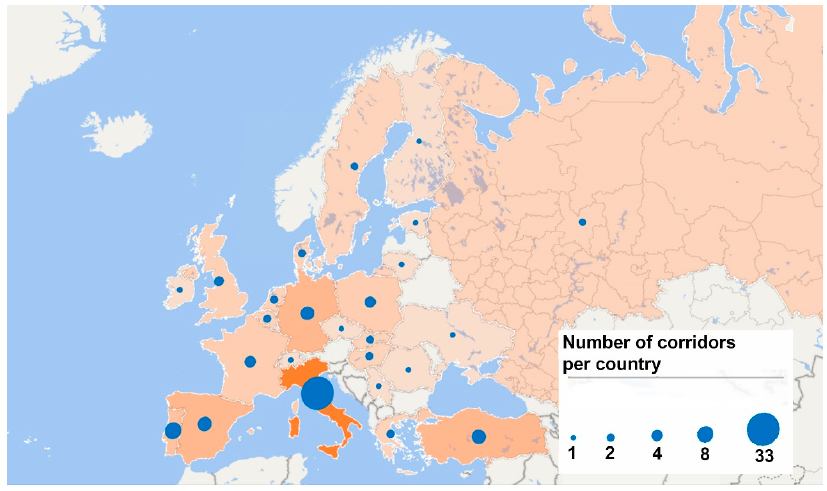
Figure 2. Location and number of landscape corridors covered in this review, by